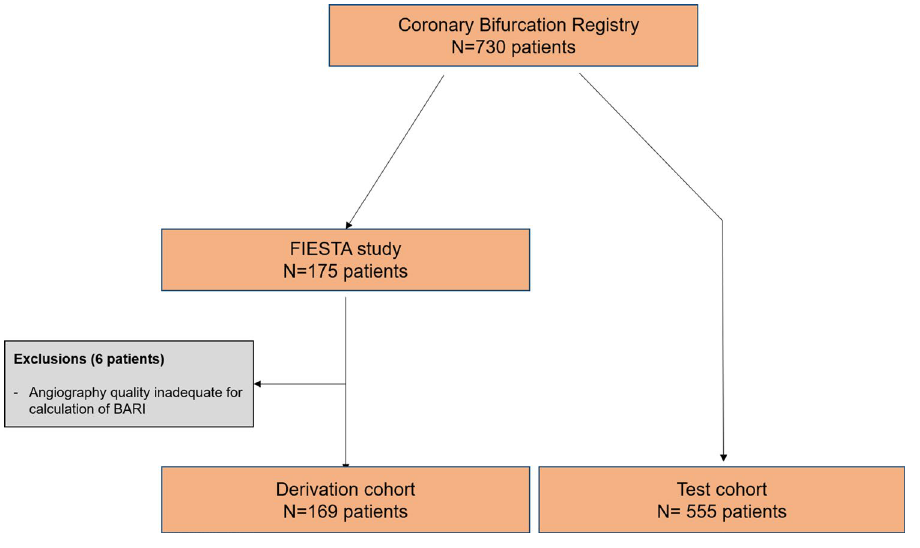
Figure 1. Patient selection flow